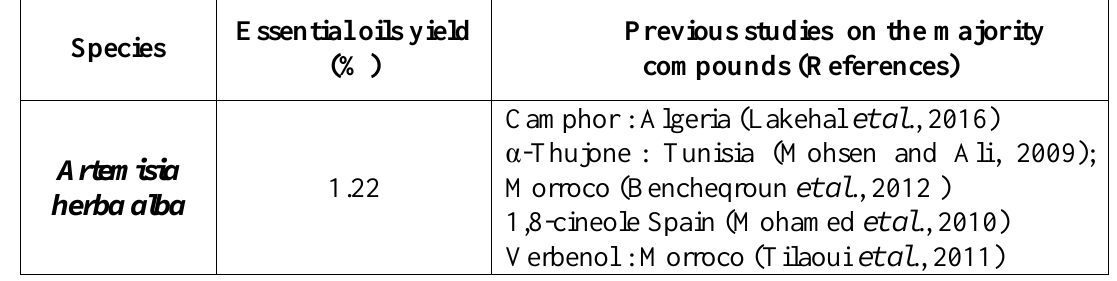
Table 1. Essential oils yield (%) and groups of compounds, region of collection